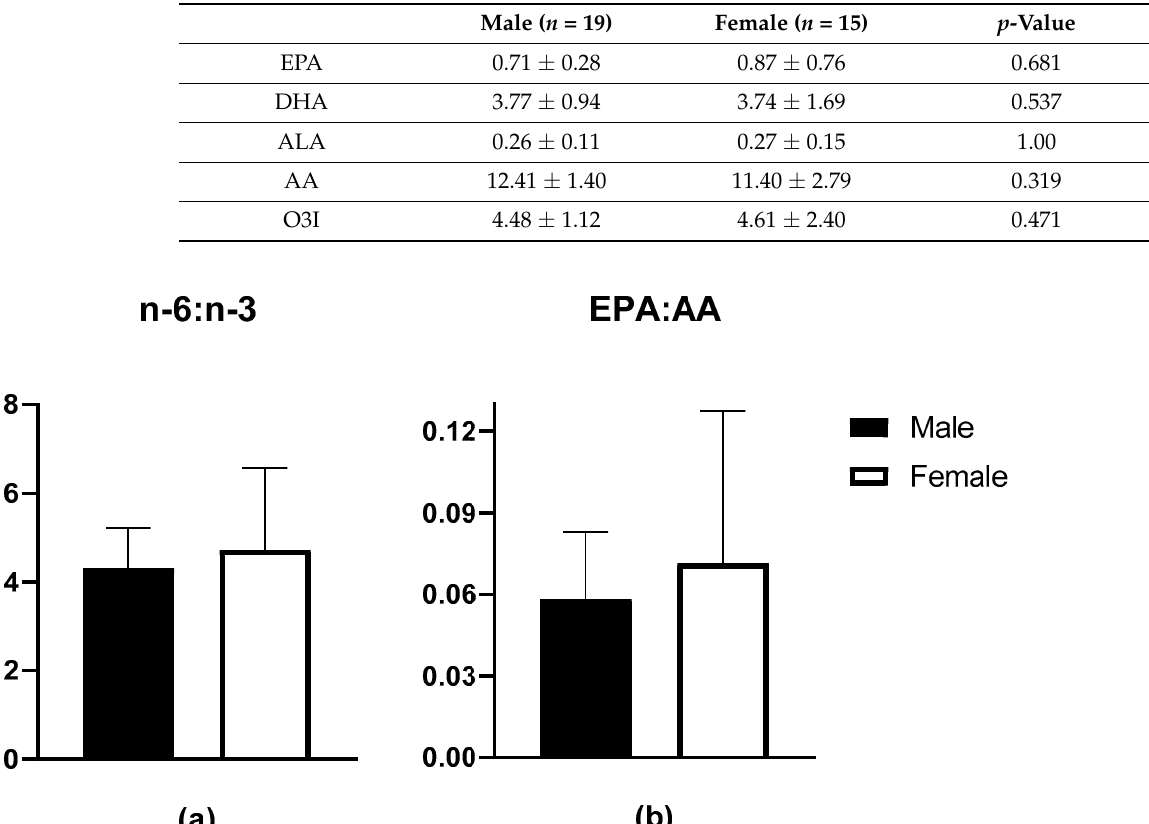
Figure 1. Erythrocyte fatty acid data for ( a ) n-6:n-3 ratio in males ( n = 19, 4.31 ± 0.91) and females ( n = 15, 4.73 ± 1.86); ( b ) EPA:AA ratio in males (0.06 ± 0.02) and females (0.07 ± 0.06).